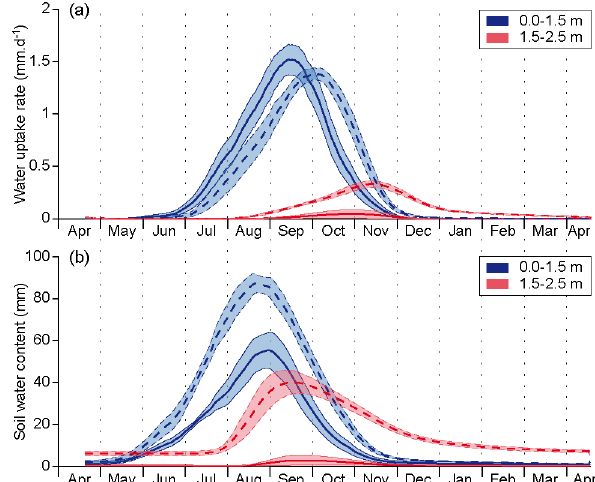
Figure 8. Estimated mean seasonal courses of (a) water uptake by plant roots and (b) soil water storage (above θ r ), separately in two active root zone layers (depths in legend) for fallow (solid lines) and millet (dashed lines) plots. See Fig. 6 for further explanation of curves and colored